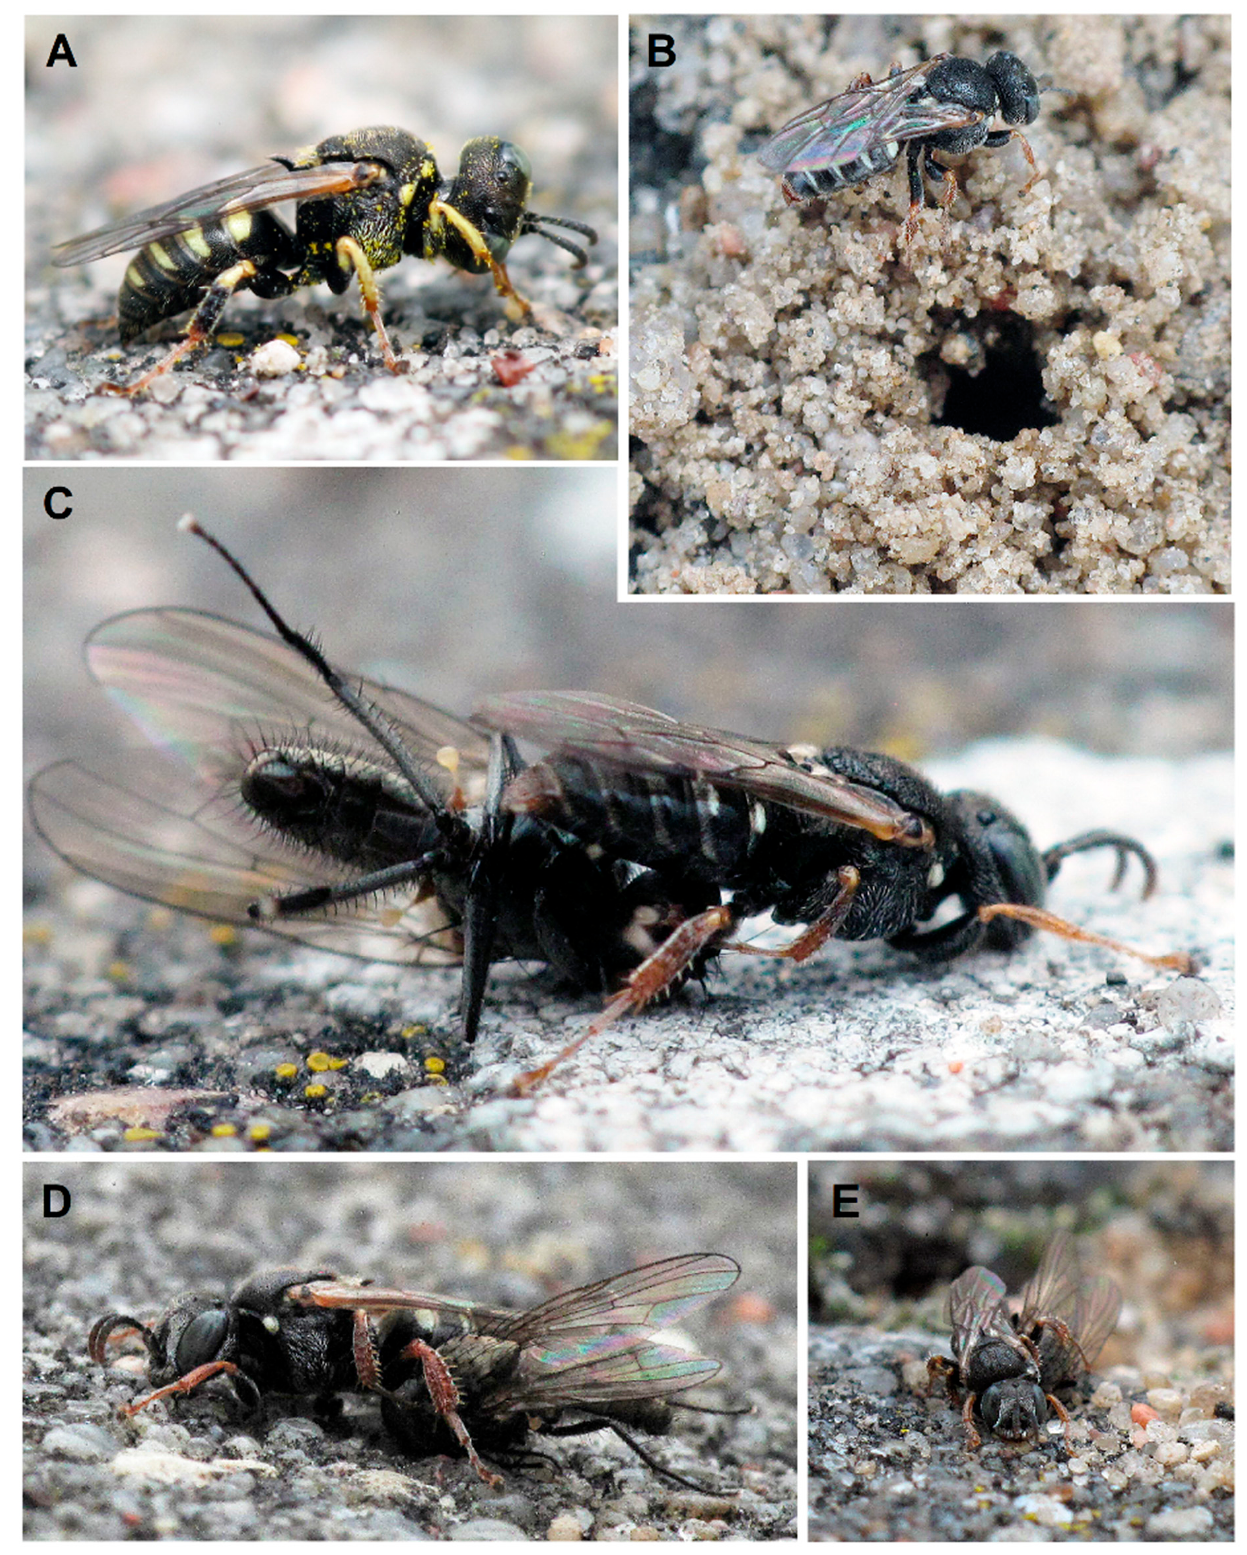
Figure 2. Adult of Oxybelus variegatus . ( A ) Male; ( B ) female in front of the nest entrance; ( C – E ) female with prey.